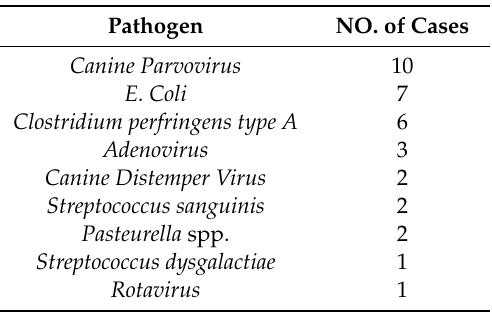
Table 2. Viruses or bacteria detected in cases of sudden and unexpected